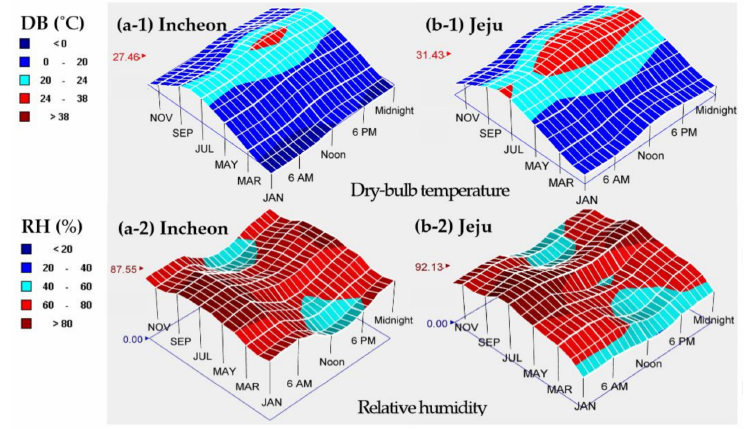
Figure 5. Comparison of the average monthly outdoor air temperature and relative